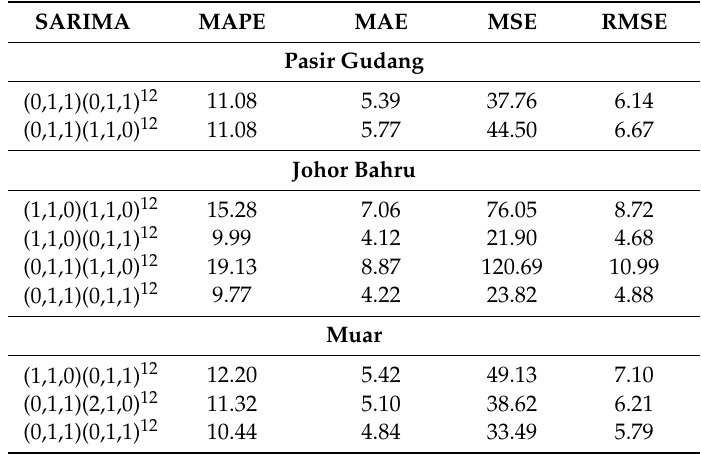
Table 5. Forecast accuracy of possible SARIMA